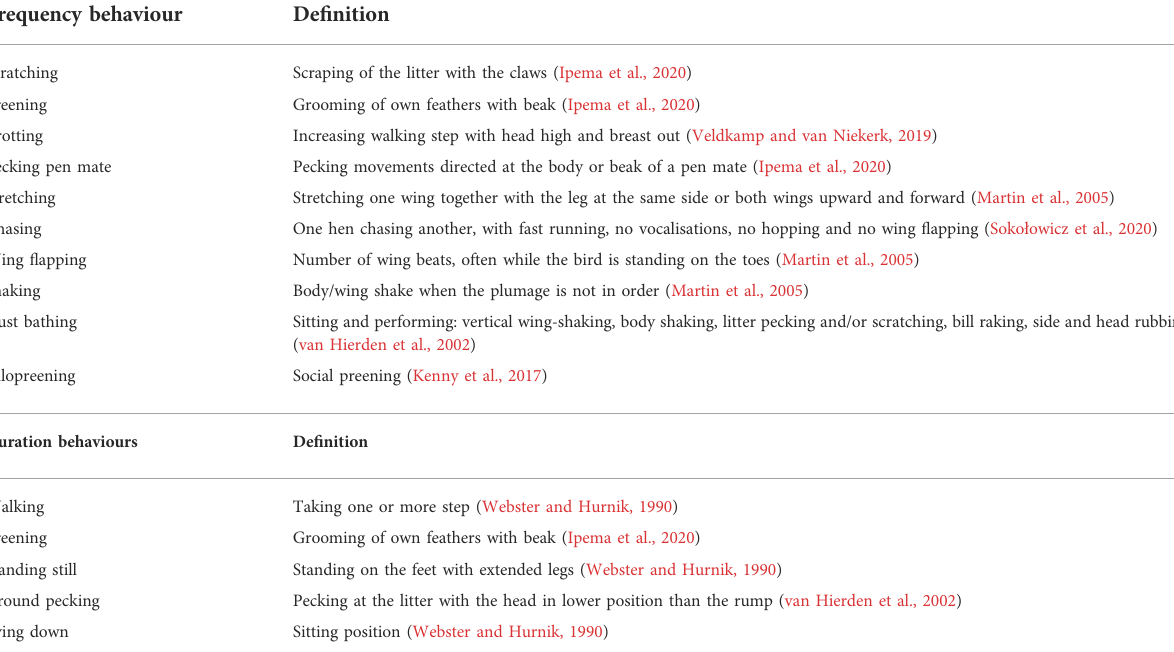
TABLE 1 Description of the broiler ethogram (frequency and duration behaviours) considered in the present study. Frequency behaviour De fi